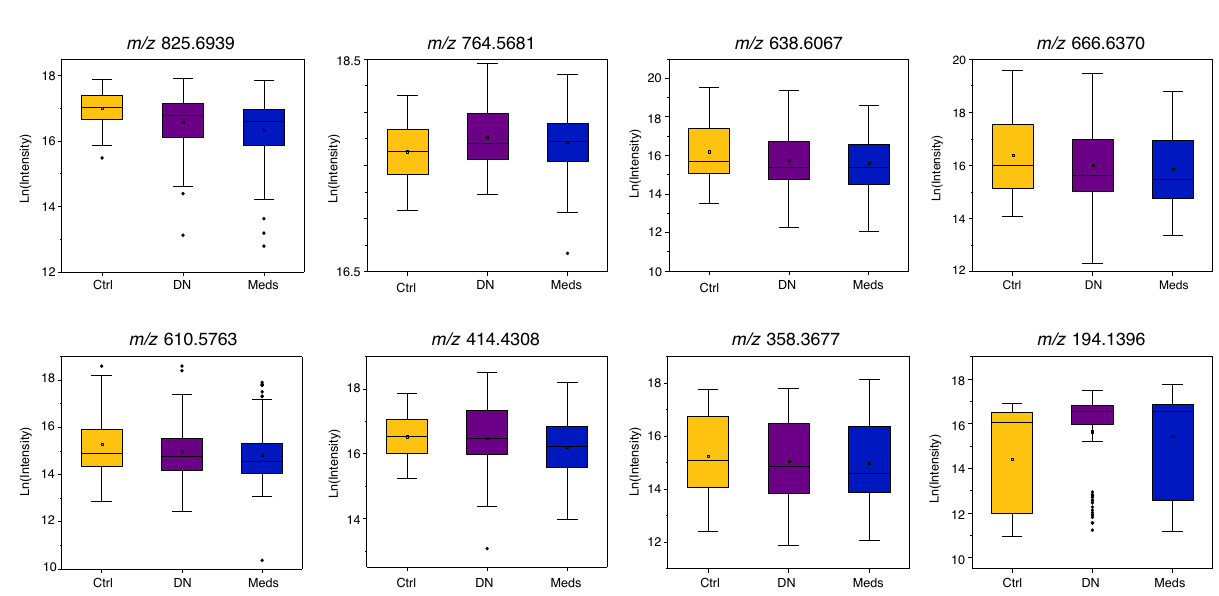
Fig. 3 Box whisker plots for each of the eight putatively annotated compounds for control (Ctrl, yellow) ( n = 56 biologically independent samples), drug naïve PD (DN, purple) ( n = 80 biologically independent samples) and medicated PD (Meds, blue) cohorts ( n = 138 biologically independent samples). Box plots display mean (square), median (line within box) and quartiles (box limits), range (whiskers) and outliers (diamond). The y -axis of each plot corresponds to the natural log of intensity values and the measured m/z value for each compound is labelled above the plot, these species correlate to the data presented in Table 2A,